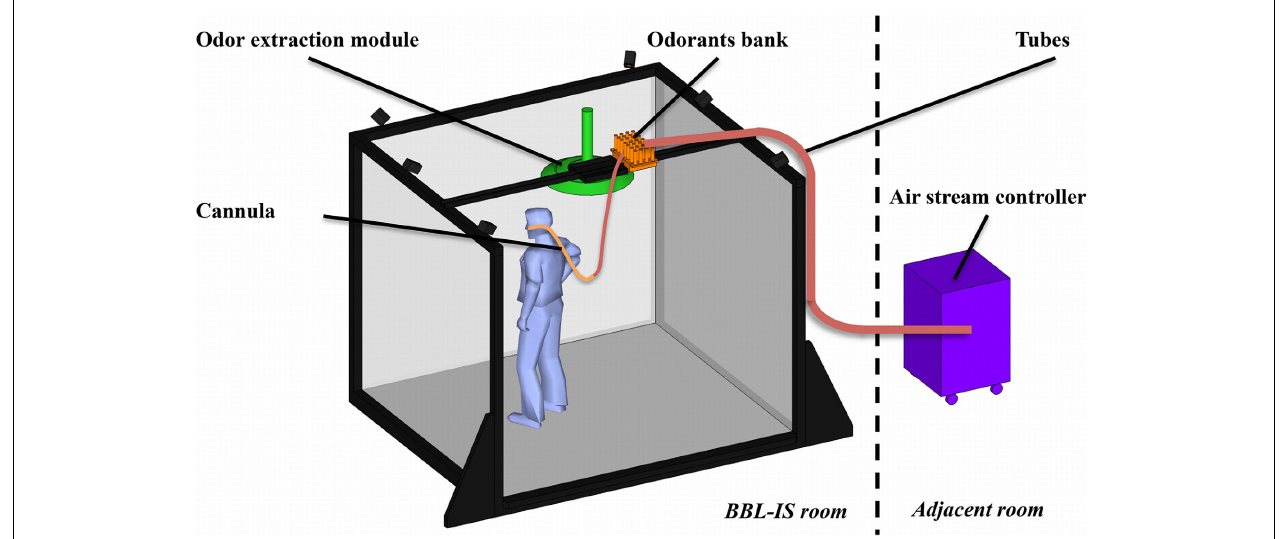
FIGURE 2 | Schematized illustration of the OD integrated in the